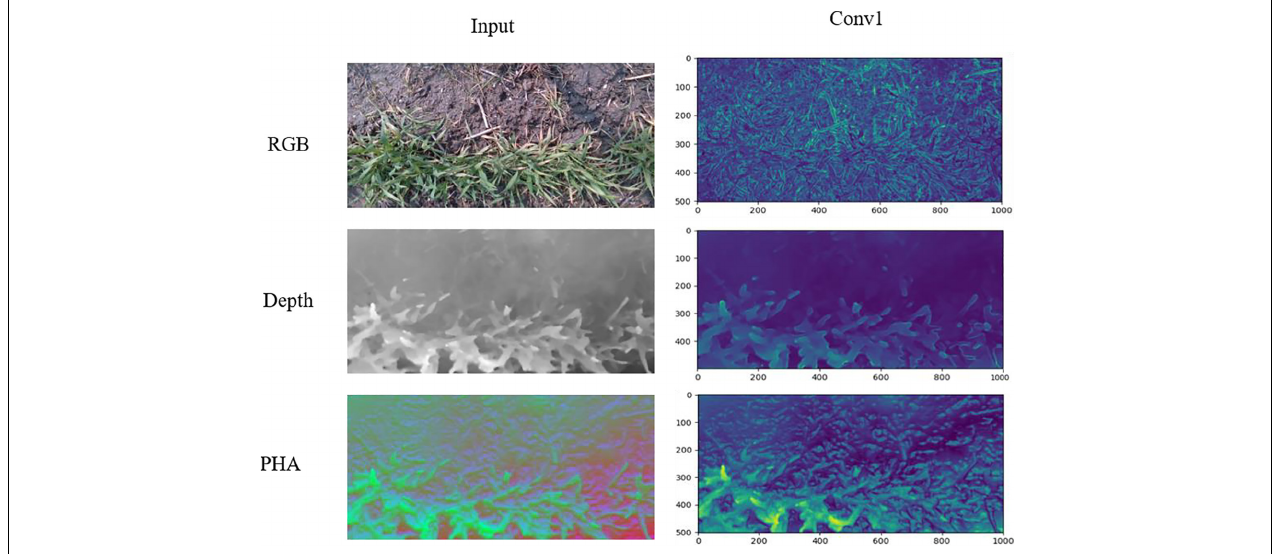
FIGURE 6 | Feature maps from first convolutional layers in VGG16 network of PHA, RGB, and depth images.